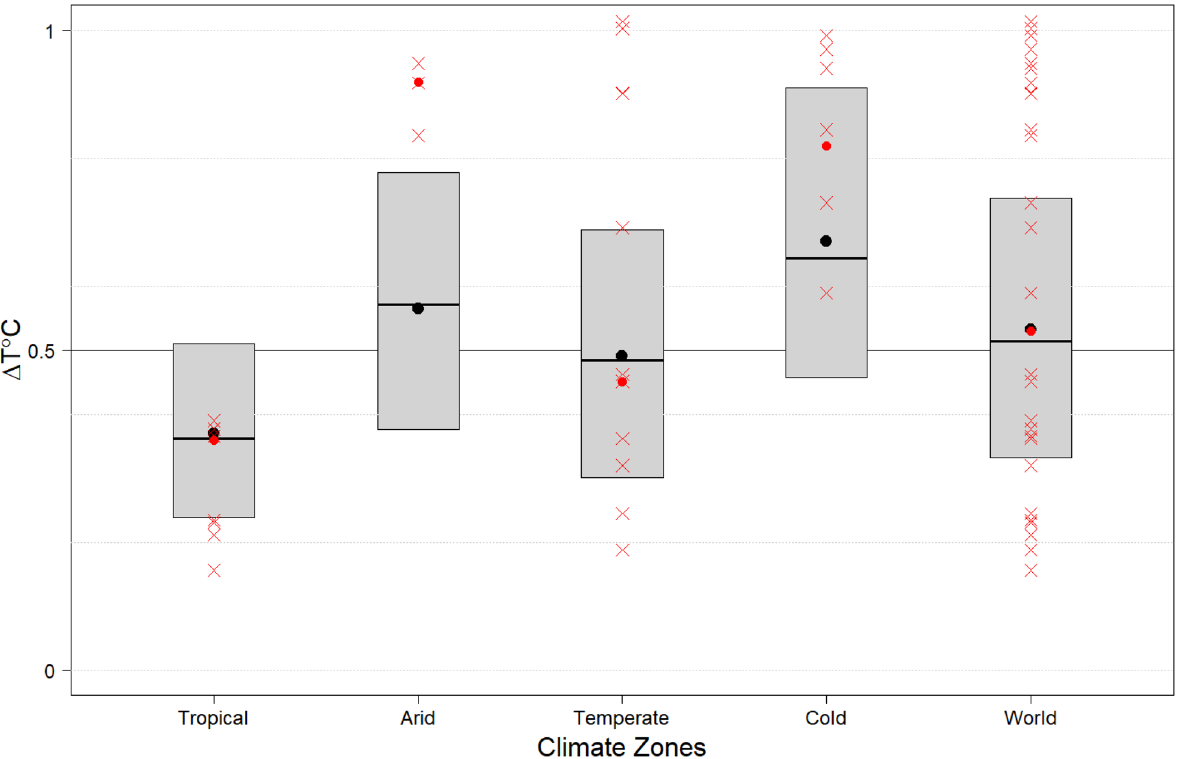
Figure 1. Change in temperature (ΔT°C). Boxplot (without whisker) showing the ΔT°C for each climate zone between the periods of 1976–1995 and 1996–2015. The ΔT°C for each wetlandscape is shown as redcrosses. Mean ΔT°C for the climate zones are shown as black points, while the red points show the mean ΔT°C for the wetlandscapes. For detailed boxplots with whiskers, see Supplementary ΔT of both the arid climate zone as a whole and the share of the arid climate zone located within the northern hemisphere (Fig. 1, black point and Fig. S6). This is also true for the wetlandscapes within the cold climate zone (where the corresponding difference is 0.15 °C). The mean ΔP (black points) is positive for all climate zones between period 1 and period 2 (ΔP > 0; Fig. 2), implying increased mean P. The median ΔP (black lines) is also positive, except for the arid climate zone where it is unchanged. The largest relative increase in mean P is seen for the tropical climate zone (Fig. 2). This increase becomes even more pronounced when expressed in absolute terms (Fig. S3 of the Supplementary Information), since precipitation is generally high in the tropics. The smallest relative change in mean P is seen for the temperate climate zone (Fig. 2), whereas the smallest absolute change is seen for the arid climate zone, due to low precipita- tion. Moreover, although the spread expressed as the interquartile range of ΔP within the tropical climate zone is the largest of all climate zones in absolute terms (Fig. S3, height of grey box), the opposite is true in relative terms (Fig. 2). Conversely, the interquartile range of ΔP within the arid climate zone is among the lowest in absolute terms (Fig. S3; together with the cold climate zone), but highest in relative terms (Fig. 2). The mean precipitation increases for tropical and temperate wetlandscapes (Fig. 2; red points) are practically identical to the precipitation increases in their respective continental-scale climate zone (Fig. 2, black points). In contrast, the arid and cold wetlandscapes have on average been exposed to precipitation decreases, whereas their corresponding climate zones as well as the share of their climate zones located within the northern hemisphere on average have experienced precipitation increases (Figs. 2, S8). Furthermore, a common characteristic of the arid, temperate and cold wetlandscapes is that the variability is considerable between individual wetlandscapes (Fig. 2; red crosses). Hence deviations from the average trend of the climate zone is common (e.g., three out of six cold wetlandscapes are subject to precipitation increases, even though the ensemble average shows a precipitation decrease). There is a non-negligible variability also among the tropical wetlandscapes, however, the vast majority (6 of 7 wetlandscapes) of those are subject to precipitation increases although not statistically significant (p > 0.05; Table S2). Considering relative changes over time, a majority (6 of 9) of the wetlandscapes with available Q data showed considerable decreases in R (− 10% < ΔR < − 35%; yellow bars in Fig. 3), two of which were statistically signifi- cant (p < 0.05; Pantanal and Anzali, Table S2). This is despite the fact that corresponding P typically either show just a modest decrease (ΔP of minus a few %; blue bars in Fig. 3), or even small increases (ΔP of plus a few %). For many (four of nine) of the wetlandscapes, R additionally show larger absolute changes than P (Figs. 3, S4), despite the fact that R is lower than P (on average 34% of P). The three wetlandscapes not showing distinct R decreases are two cold and one tropical wetlandscape, namely the Norrström drainage basin, Sweden (ID 22;